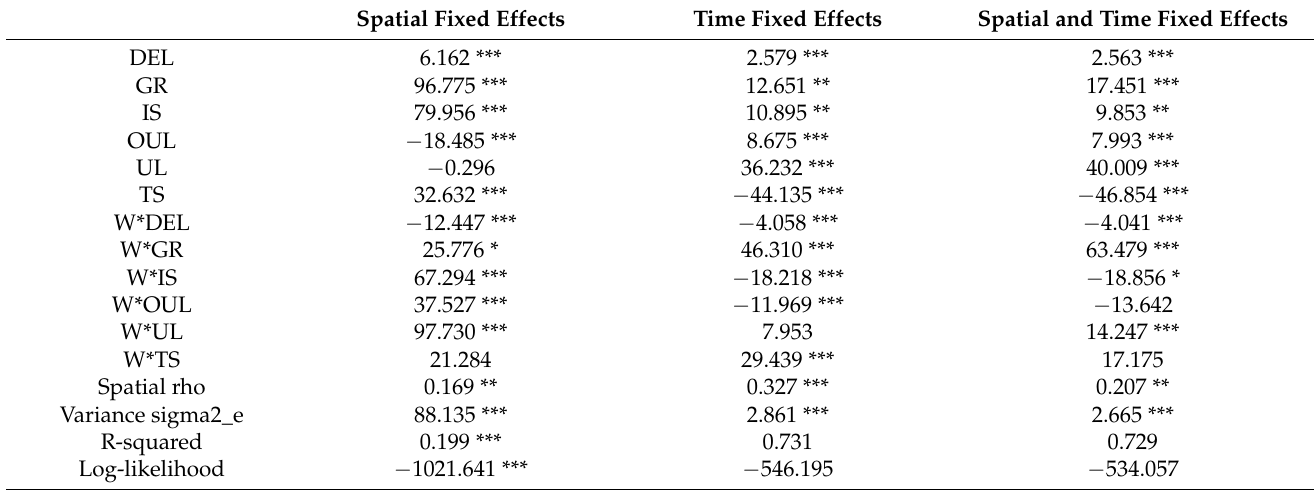
Table 7. The regression results of